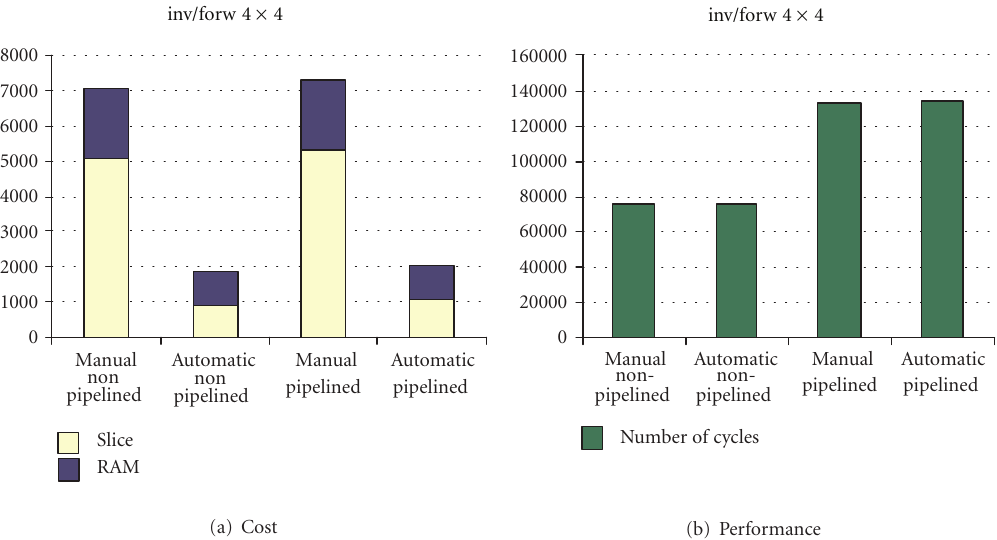
Figure 19: inv/forw 4 × 4 : number of slices, number of RAMs, and number of cycles for manually selected and automatically generated data paths.